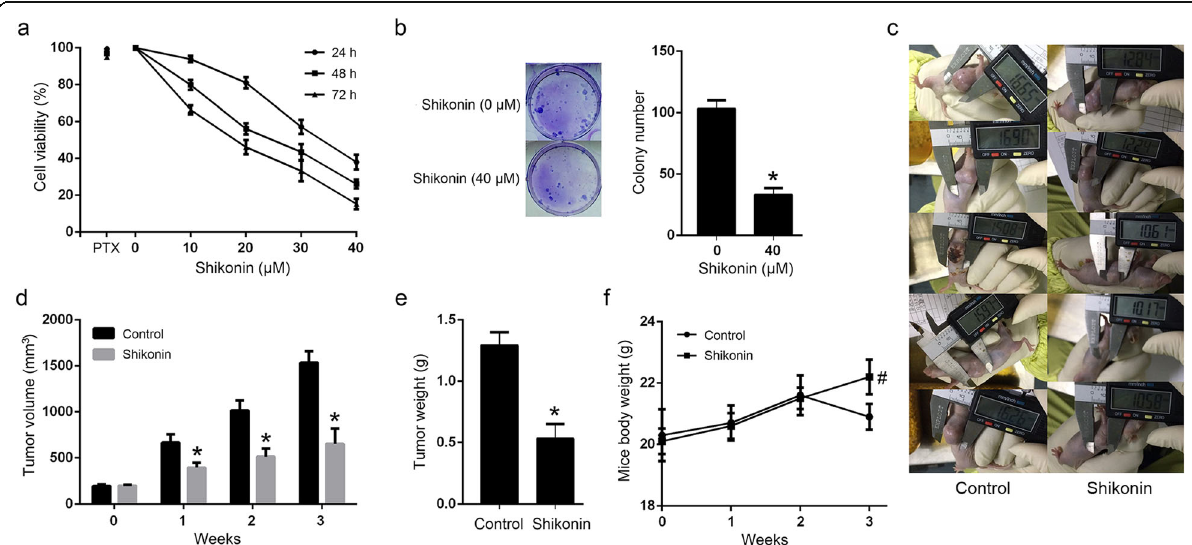
Fig. 1 Shikonin decreased paclitaxel-resistant NSCLC cell viability and inhibited the growth of xenograft tumors. a Shikonin considerably decreased cell viability in A549/PTX cells in a dose- and time-dependent manner. b shikonin inhibited the colony formation activity of A549/PTX cells at 48 h. c , d Shikonin inhibited the tumor volume of A549/PTX xenograft. e Shikonin inhibited the tumor weight of A549/PTX xenograft. f Shikonin did not decrease the mice ’ s body weight. *Statistically significant difference ( p < 0.05). #No statistically significant difference( p >